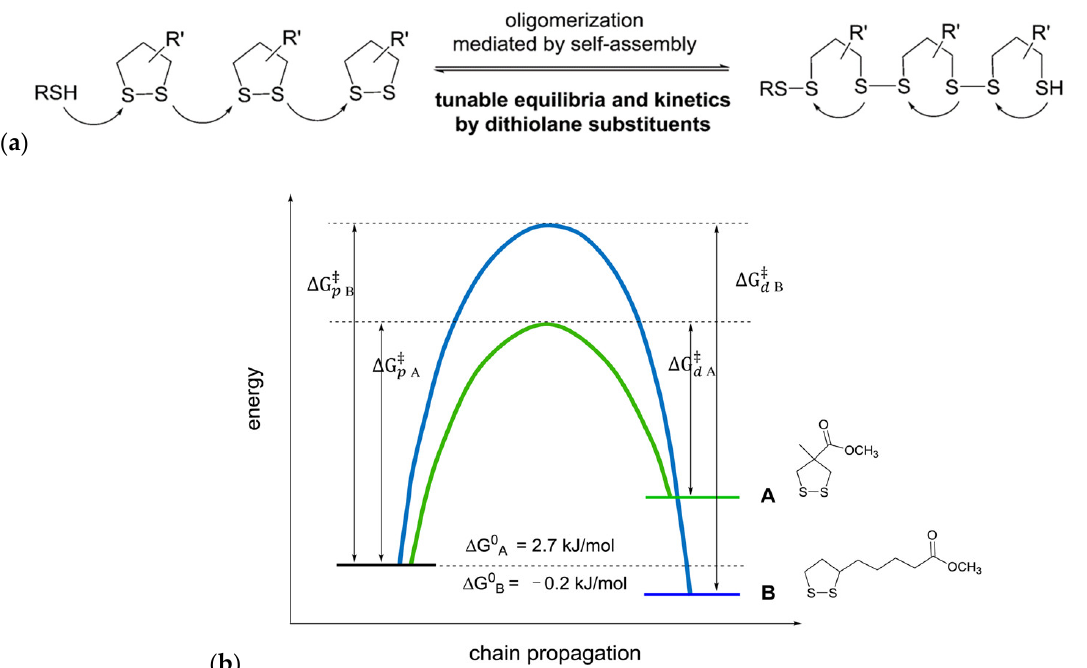
Figure 30. ( a ) Ring opening polymerization of 1,2-ditholane pendant group in the hydrophobic micelle cores upon exposure to a small molecule thiol. ( b ) Ring opening polymerization energy profiles (relative) for TMCLA (green) and TMCDT (blue) monomers. Reprinted with permission from [31]. Copyright (2014) American Chemical